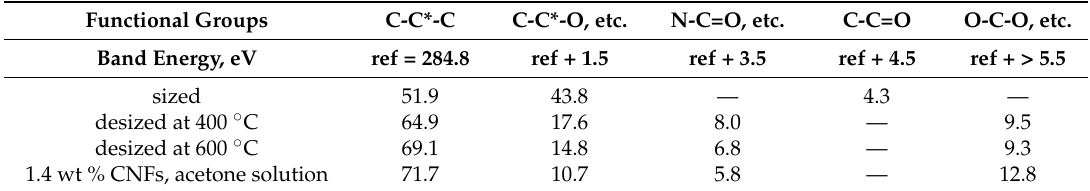
Table 4. Carbon bond composition (%) of the fiber surfaces determined by measuring the relative areas of XPS